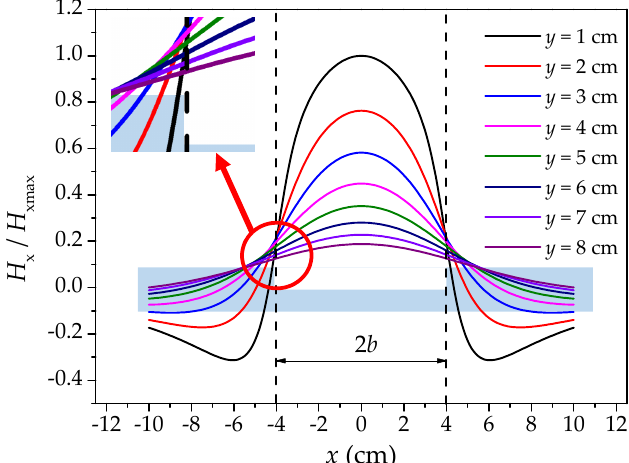
Figure 2. The normalized magnetic field intensity signal of the theoretical model of the rectangular defect. X : the coordinate of length direction of the ferromagnetic material with the center of corrosion defect as the origin; H x / H xmax : the ratio of the magnetic field intensity to its maximum value; b : the half of corrosion width of the defect; y : the lift off height.